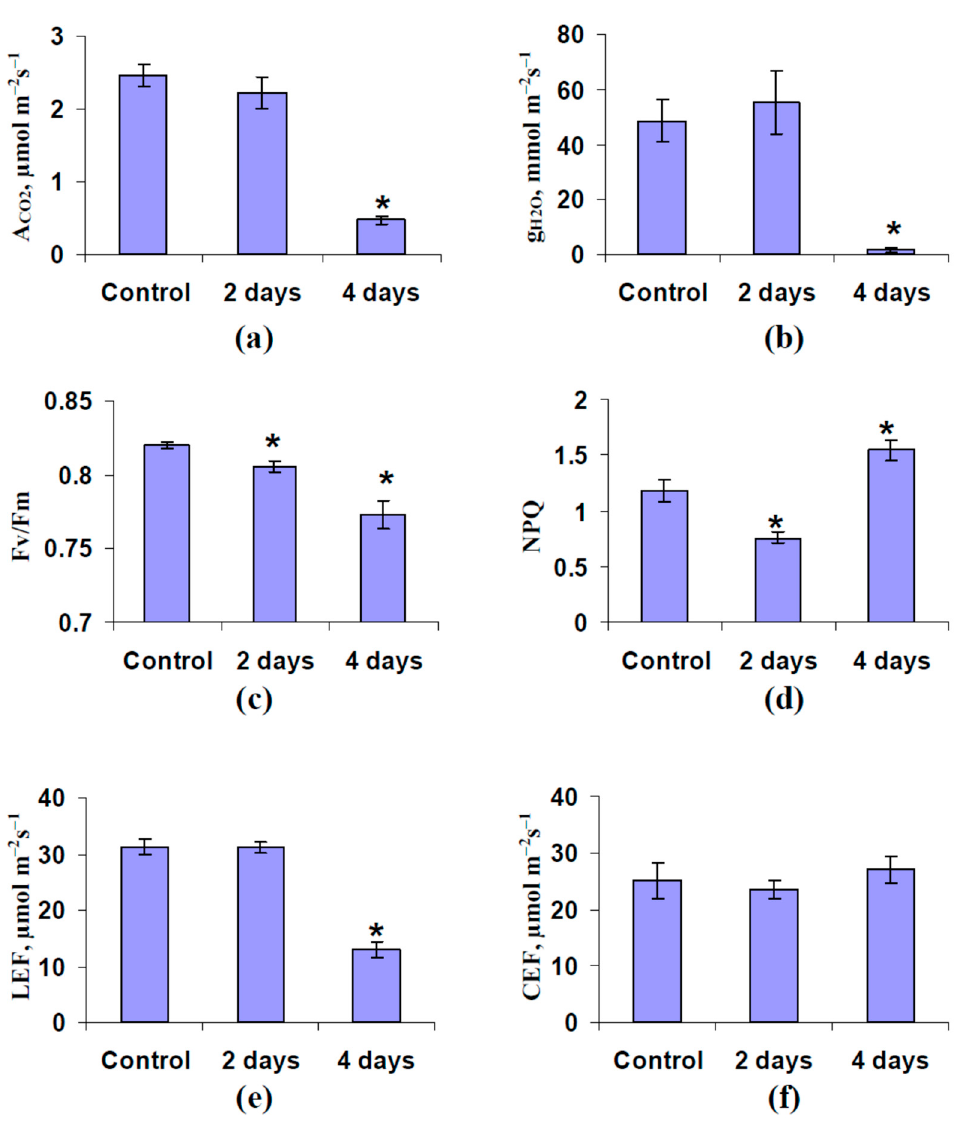
Figure 1. Influence of soil water shortage on the photosynthetic CO 2 assimilation (A CO2 ) ( a ), leaf stomatal conductance (g H2O ) ( b ), maximal quantum yield of photosystem II (Fv/Fm) ( c ), non- photochemical quenching of the chlorophyll fluorescence (NPQ) ( d ), photosynthetic linear electron flow (LEF) ( e ), and cyclic electron flow around photosystem I (CEF) ( f ) in pea seedlings ( n = 6). n was the quantity of investigated seedlings. Water shortage was initiated by the termination of irrigation of plants. Parameters were measured in the second mature leaf. A CO2 was calculated as the difference between CO 2 assimilation (A) under light and dark conditions. *, the parameter significantly differed from the one in control pea seedlings ( p < 0.05, Student’s t -test).